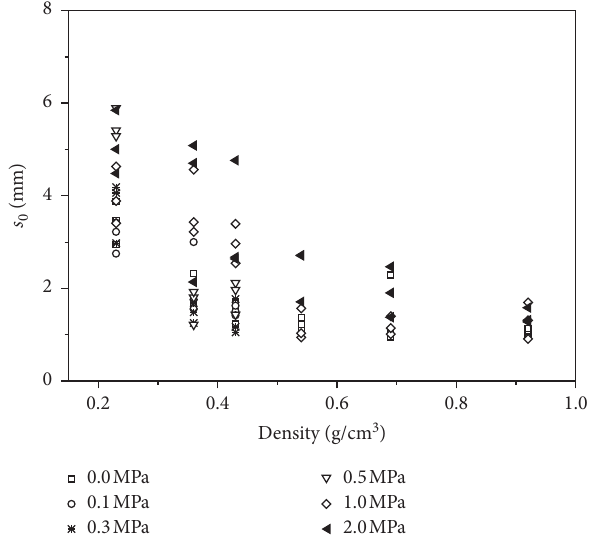
Figure 7: Relationship between s